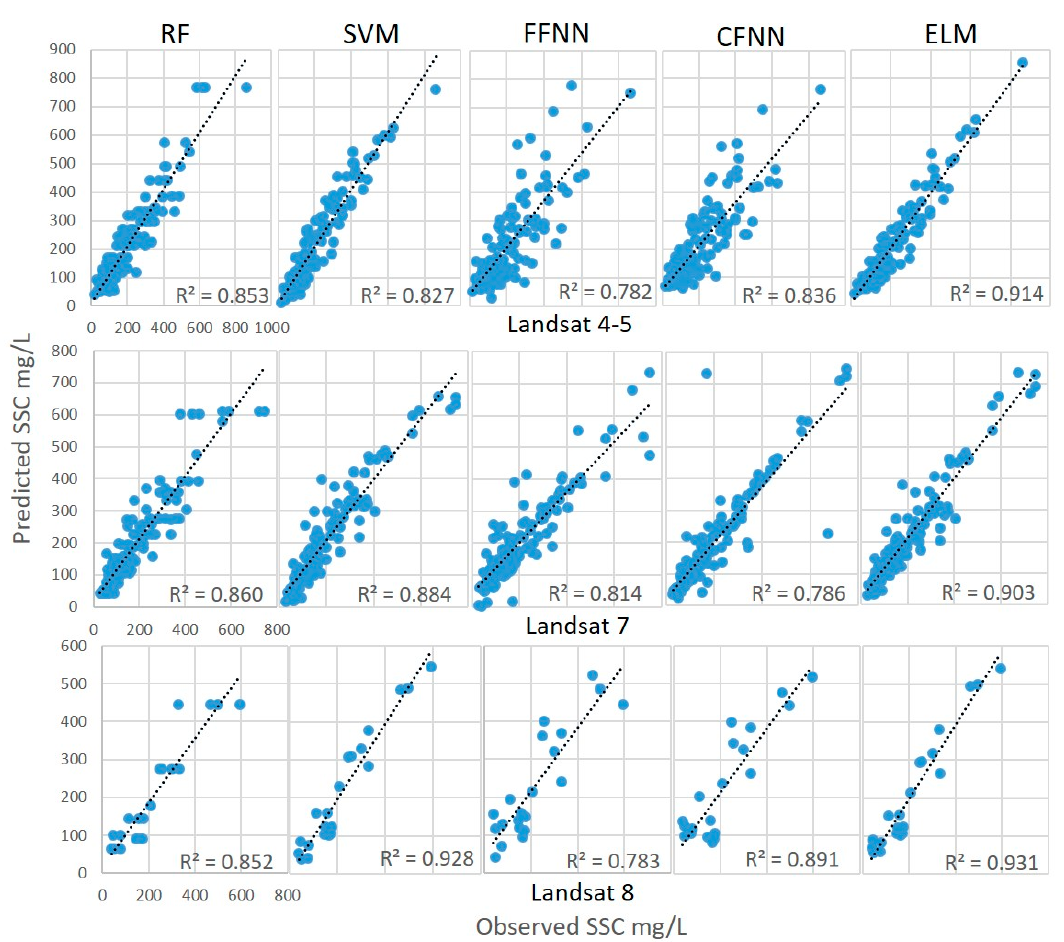
Figure 3. Plots of the observed versus predicted SSC values when applied to the testing dataset. Plots are arranged by sensor and modeling technique with R 2 values representing the overall fit of the model.